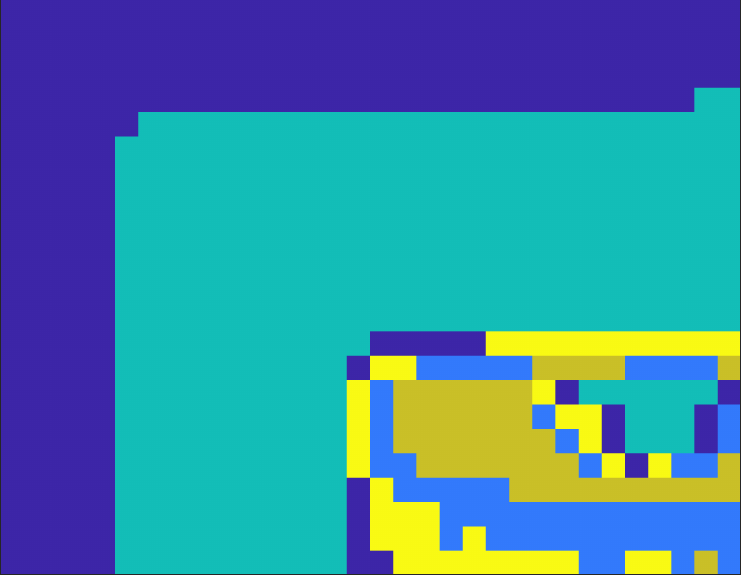
Figure 18. Image segmentation obtained with the k-means algorithm for the amplitude frequency spectrum in the time